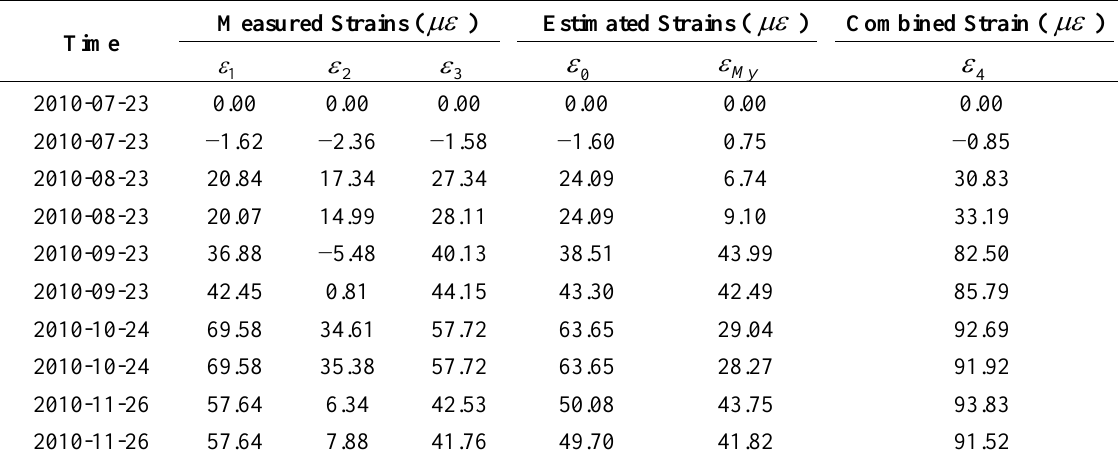
Table 2. Measured strains and estimated strain of in Zone 1.